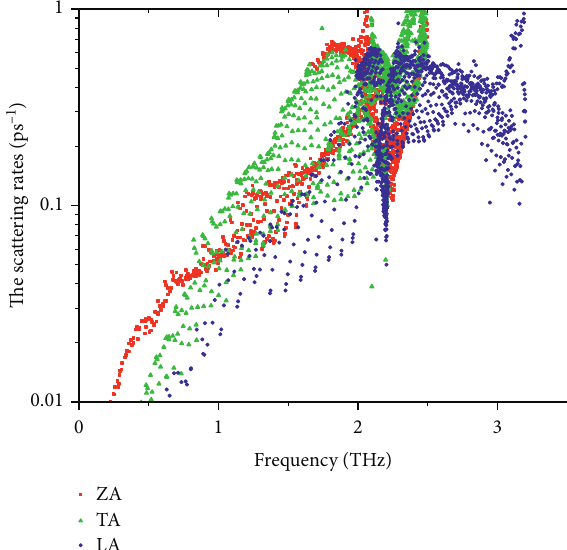
Figure 4: The phonon scattering rates of monolayer CaHBr at room temperature. The red squares (ZA), green triangles (TA), and blue circles (LA) are the acoustic modes.